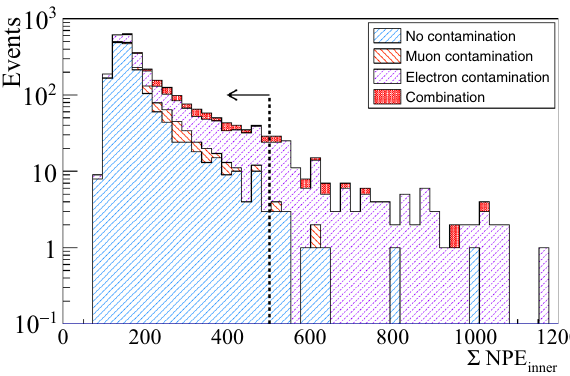
Fig. 2 PMTpulseshapecharacterization.Log-normalfittotheaverage pulse shape across all PMTs. The pulse shape is normalized to unit area, hence voltage is reported in arbitrary units. The fit parameters reported are the mean and sigma of the log normal form. Taken from [5] SPE distribution and an average was found across all PMTs.